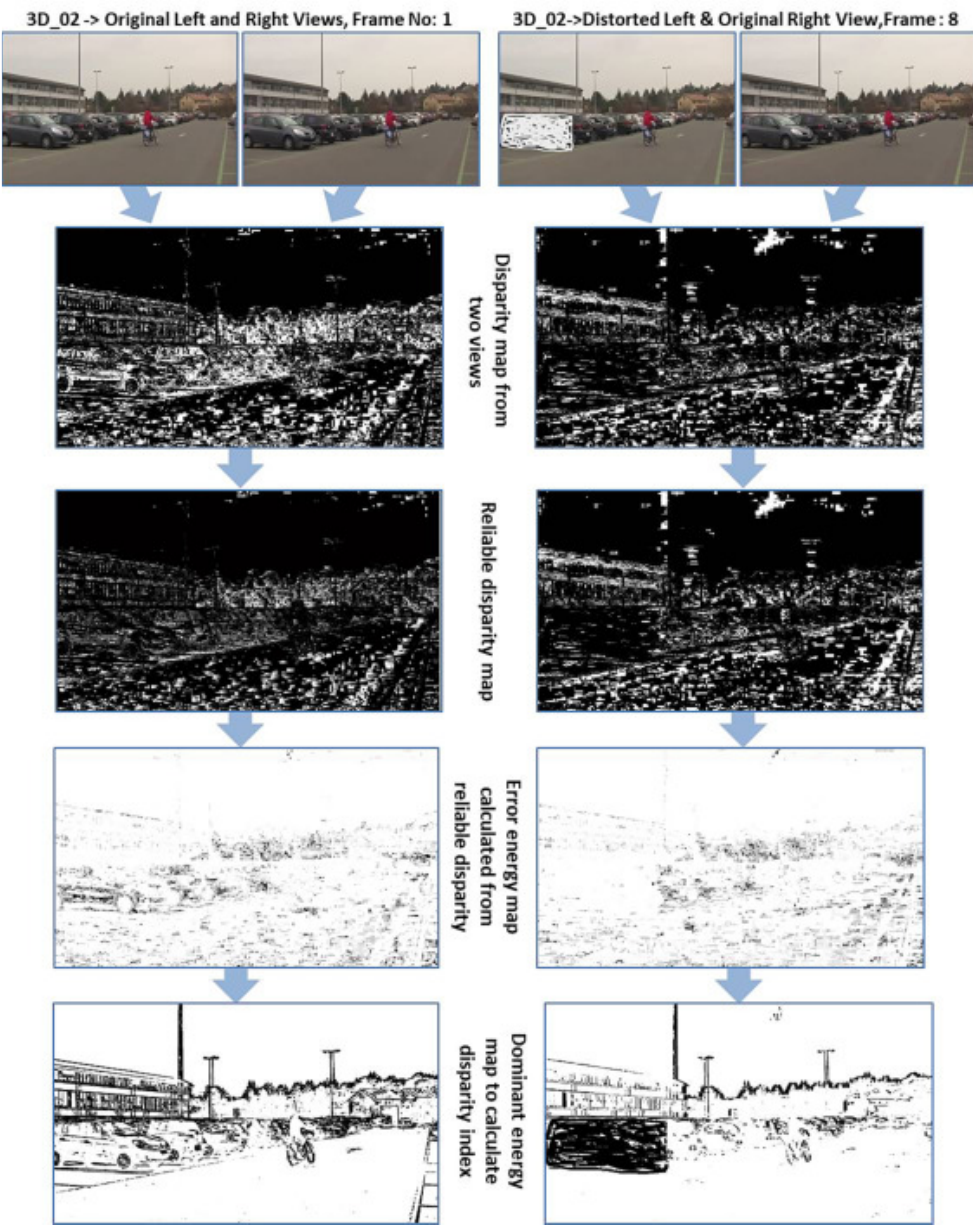
Figure 5. Steps for calculating disparity index from left and right frames of the Bicycle Riding